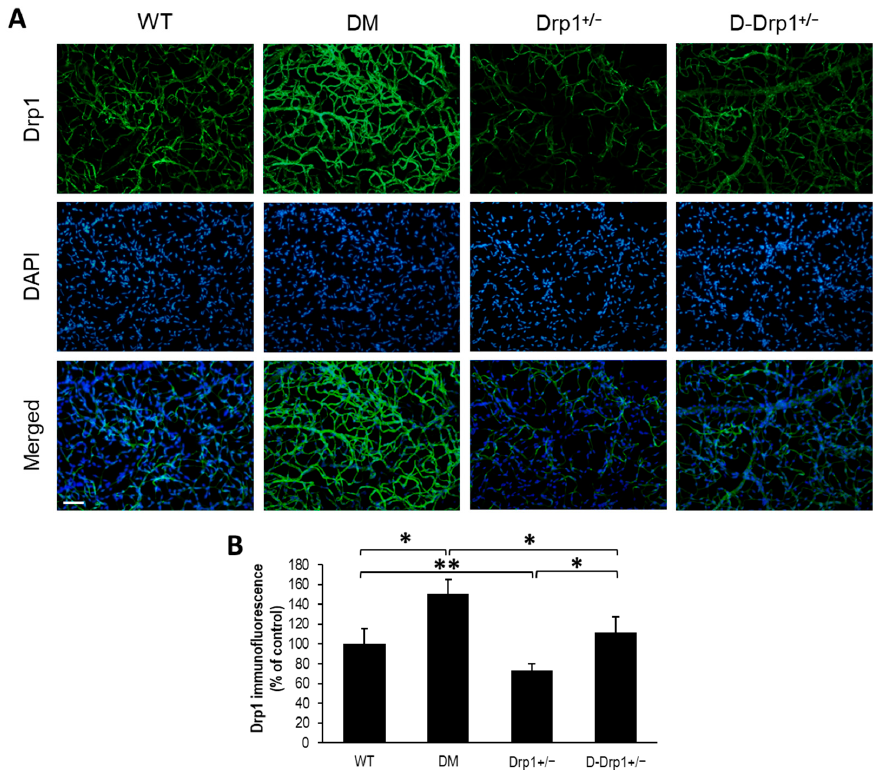
Figure 2. Drp1 +/ − mice exhibit reduced Drp1 immunofluorescence in the retinal capillary network. ( A ) Representative images of Drp1 immunofluorescence (green) and DAPI (blue) in retinal capillaries of wild-type (WT), diabetic (DM), Drp1 +/ − , and diabetic Drp1 +/ − (D-Drp1 +/ − ) mice. Scale bar = 100 µ m. ( B ) Graphical illustration of cumulative data shows decreased Drp1 immunofluorescence in retinal capillaries of Drp1 +/ − mice compared to that of WT mice. * p < 0.01, n = 6; ** p < 0.05, n = 6.